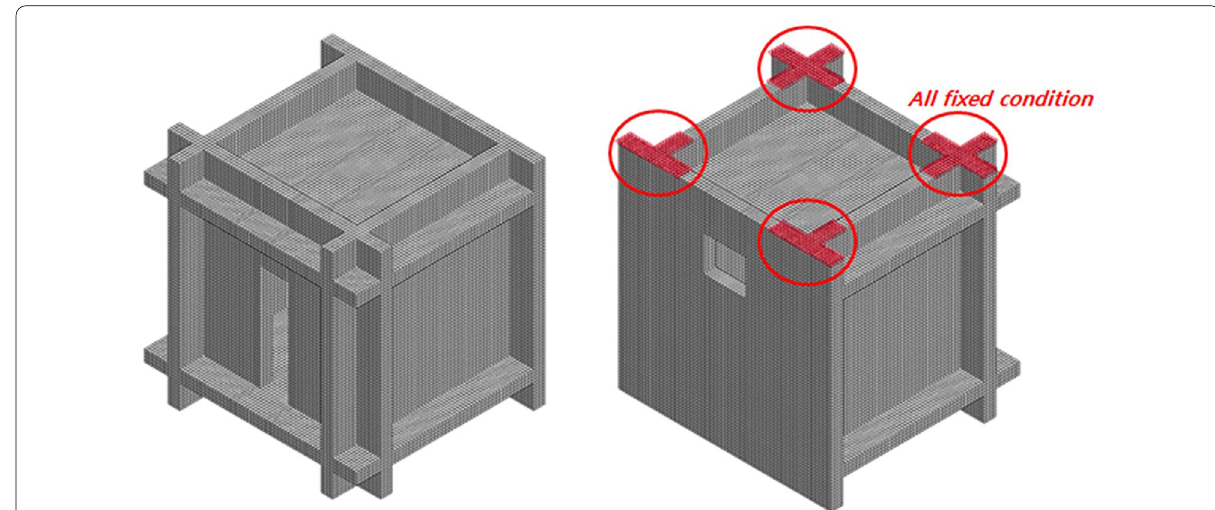
Fig. 18 Boundary condition of the reinforced concrete room.